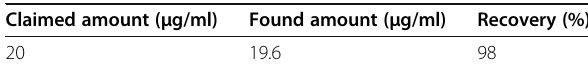
Table 7 Analysis of clotrimazole